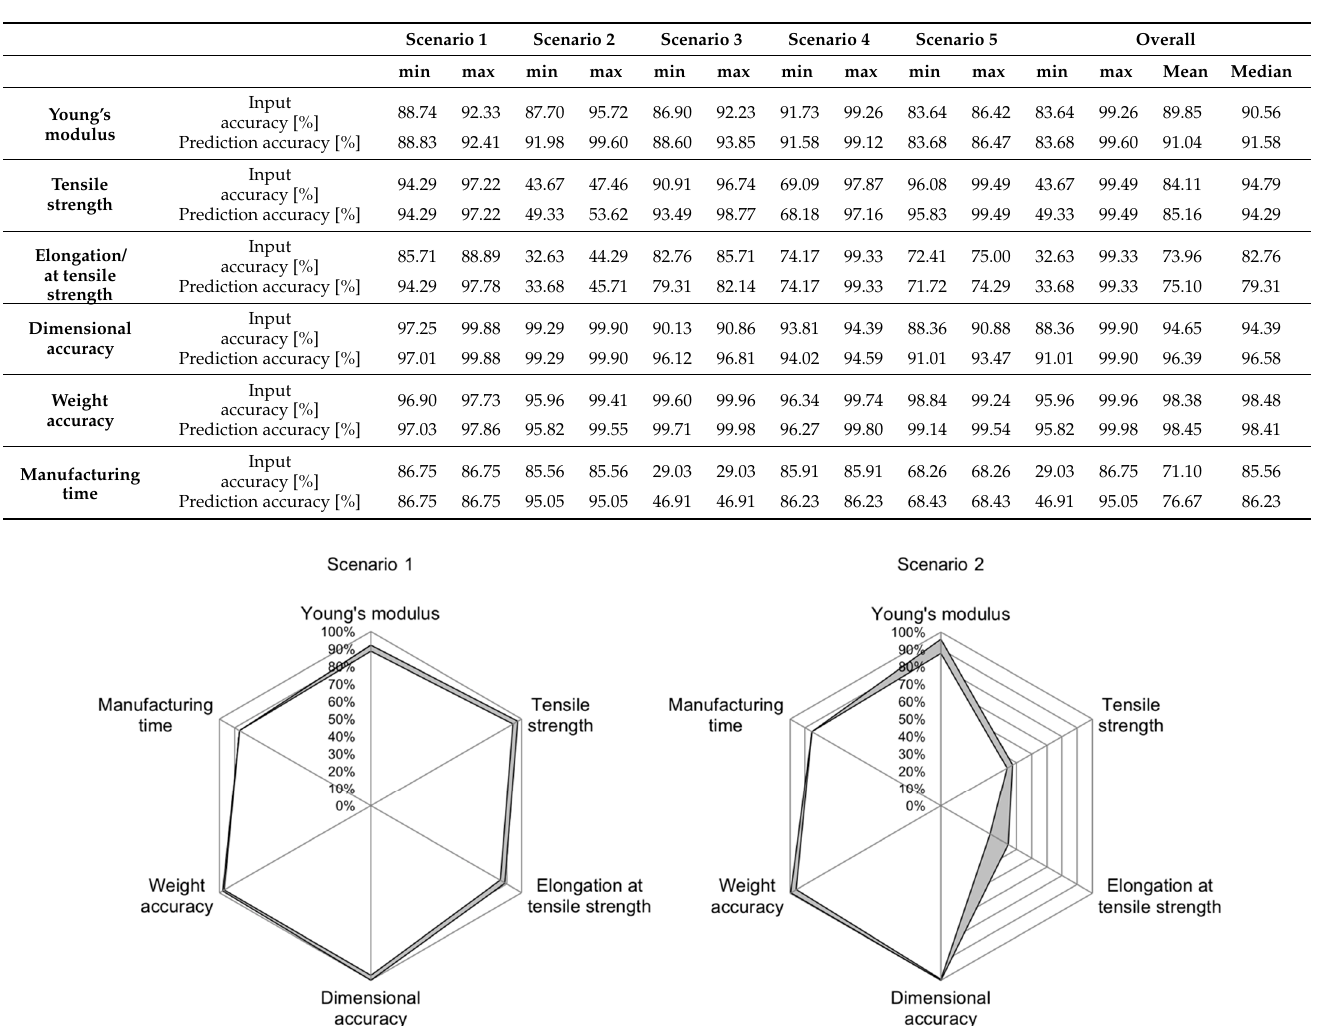
Table 6. Results of accuracy analysis, listing input (Equation (23)) and prediction accuracy (Equation (24)) for all scenarios.